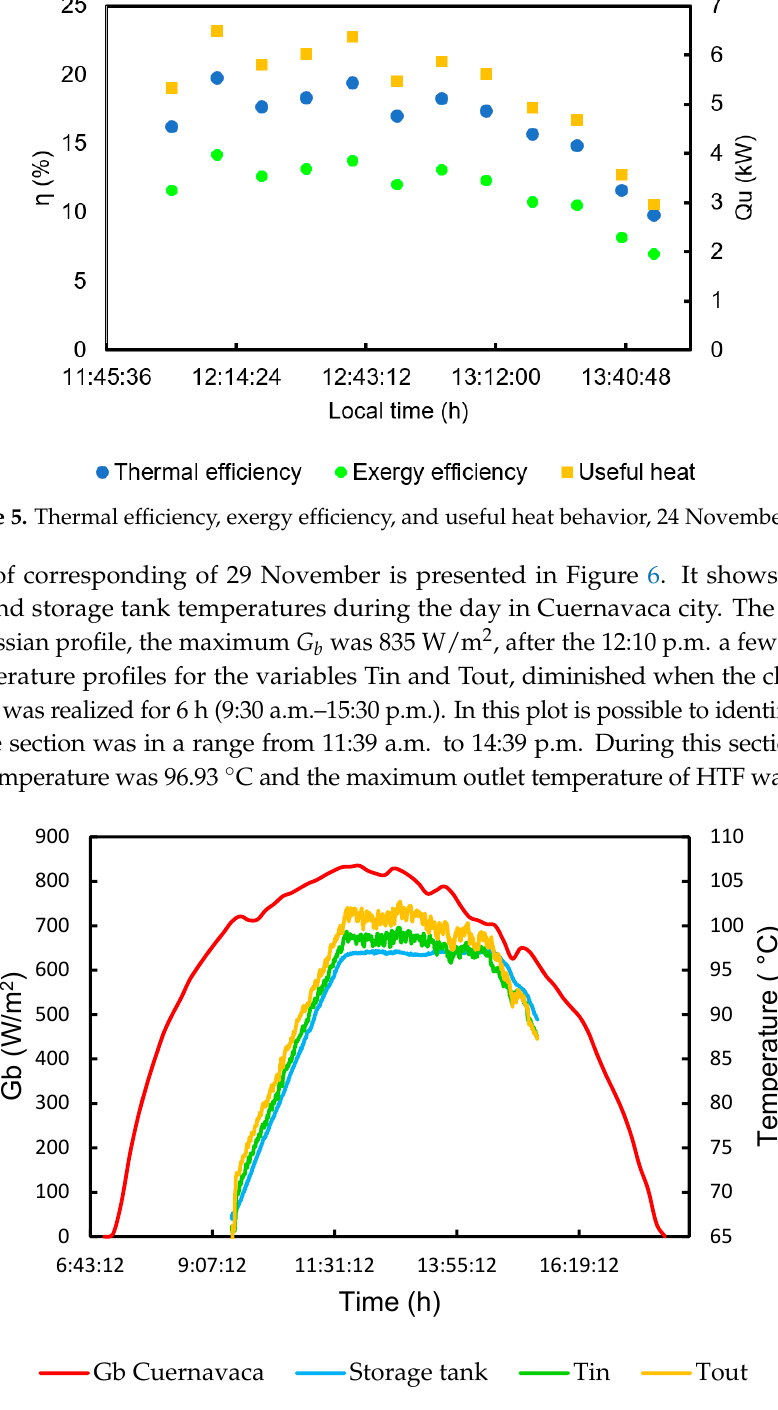
Figure 6. Behavior G b and outlet, inlet and storage tank temperatures, 29 November 2017.